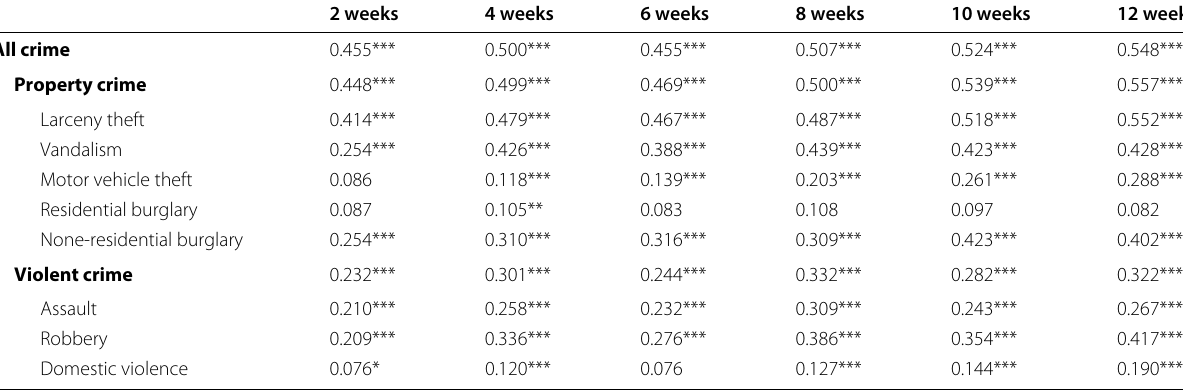
Table 2 The results of STSH index (Q statistics) between crime distribution and HAZs across six TOs in